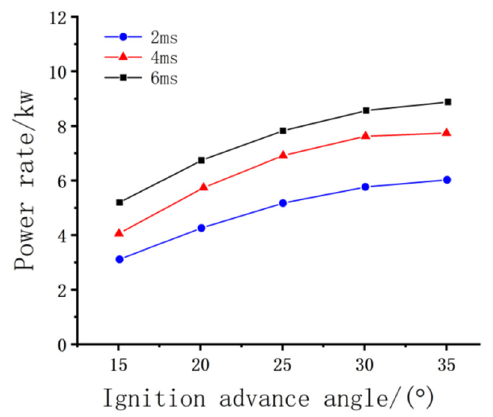
Figure 19. Influence of the ignition parameters on engine power.